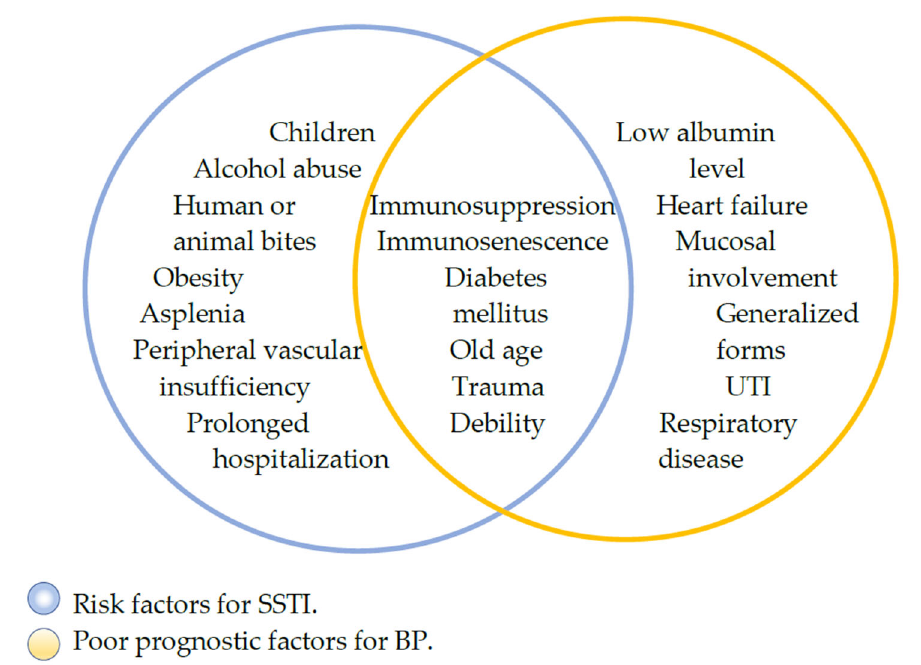
Figure 2. Diagram of shared risk factors for NF and poor outcomes of BP.